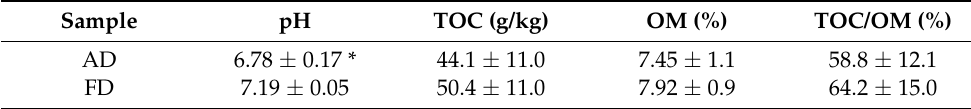
Table 1. Basic sediment properties in AD and FD samples.